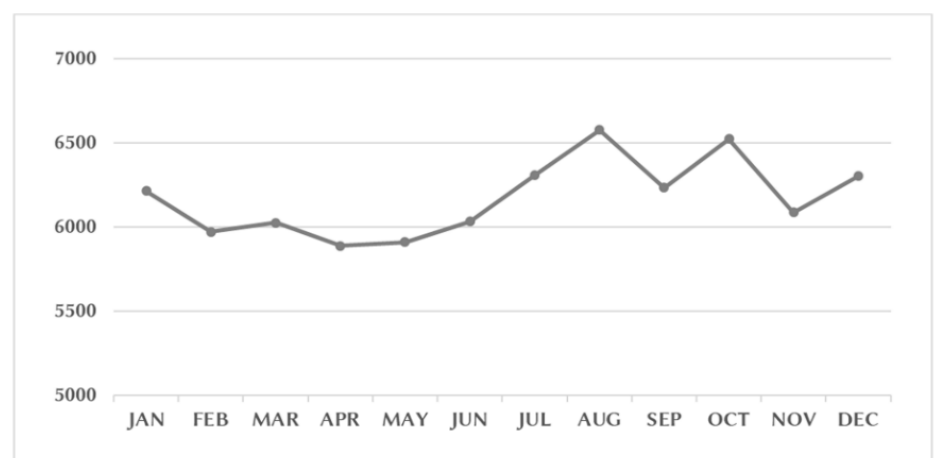
Figure 2. The monthly ED visits of prostate cancer patients from January 1997 to December 2013.